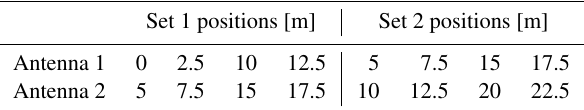
Table 2. Deployment scheme of the static antenna array in GEO3 for the transmission survey. The positions are referenced in meters from the bottom of the